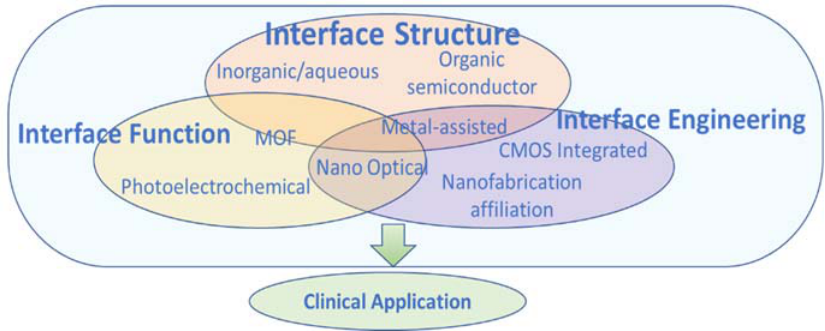
Scheme 1. Summary framework of interface structure for sensor development.